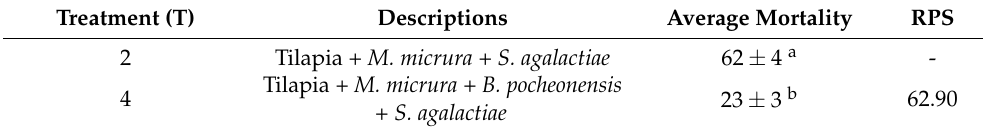
Table 3. Mortality (%) and relative percentage survival (RPS) of tilapia larvae after challenged with Streptococcus agalactiae following 10 days of the